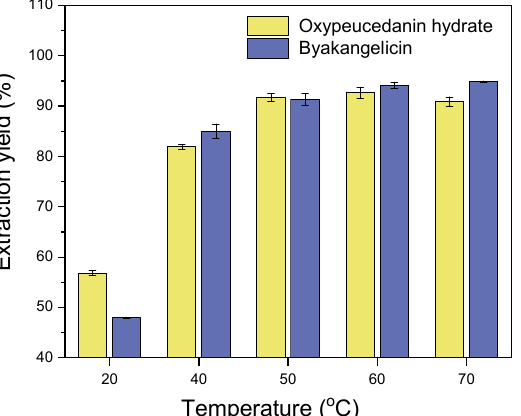
Figure 4. Effect of temperature on the extraction of oxypeucedanin hydrate and byakangelicin.